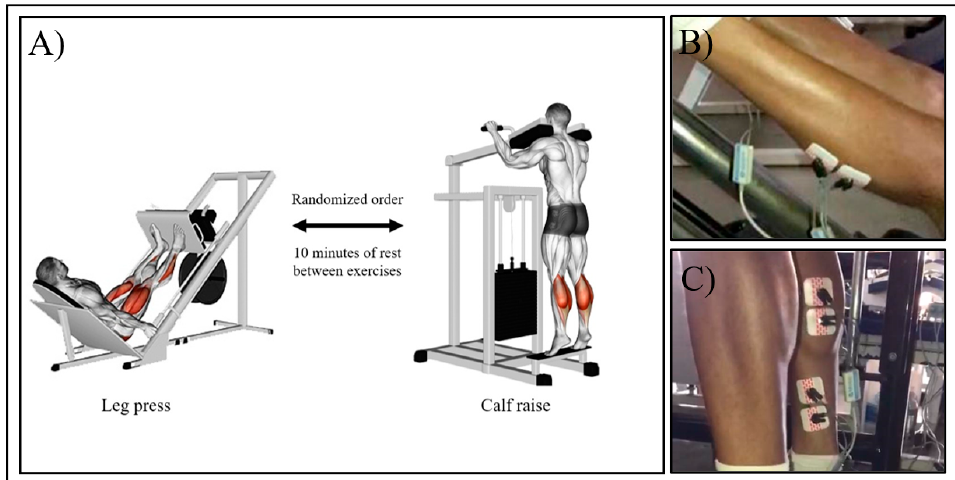
Figure 1. Illustration of exercise testing procedure ( A ), and electrode position during leg press ( B ) and calf raise ( C ).